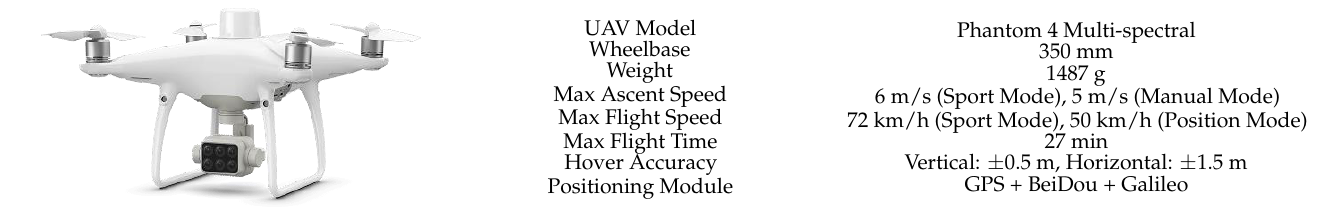
Figure 1. Geographic location of study area: ( a ) administrative map; ( b ) DOM; ( c ) 3D model. Table 1. Parameters of DJI Phantom 4 PRO.